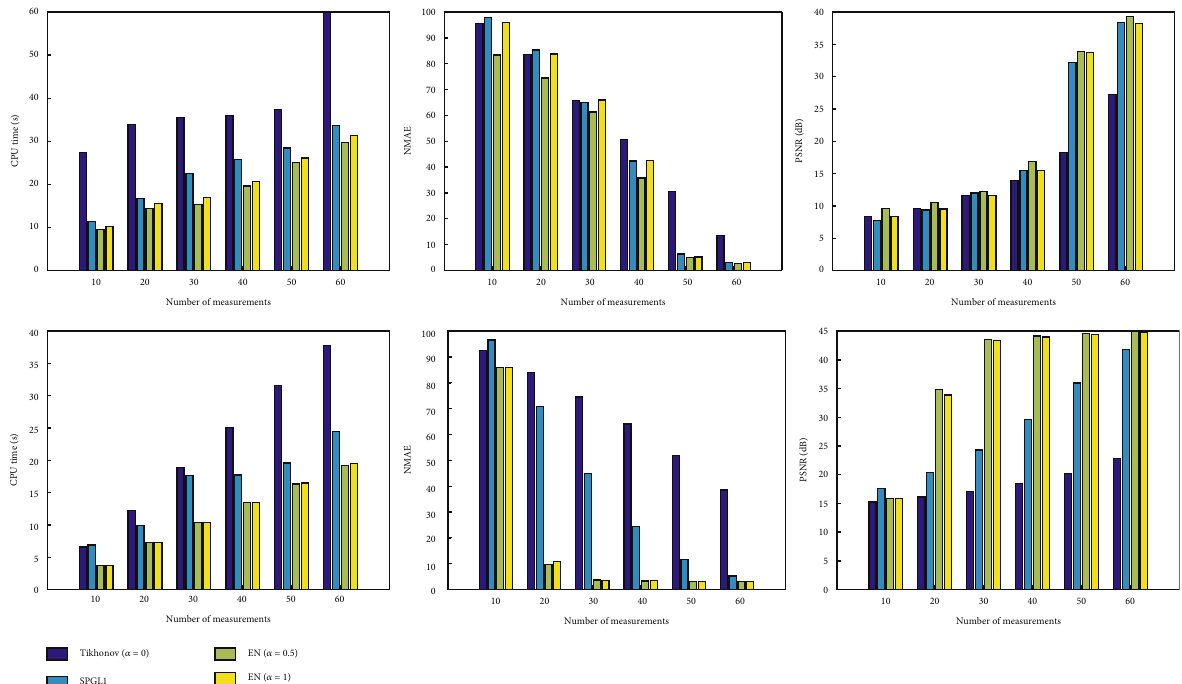
Figure 4: The histograms of numerical phantom results. The fi rst and second rows represent the results of the breast phantom and the blood vessel phantom, respectively. The fi rst to third columns are the values of evaluation index CPU time, NMAE, and PSNR as a function of the number of measurements.